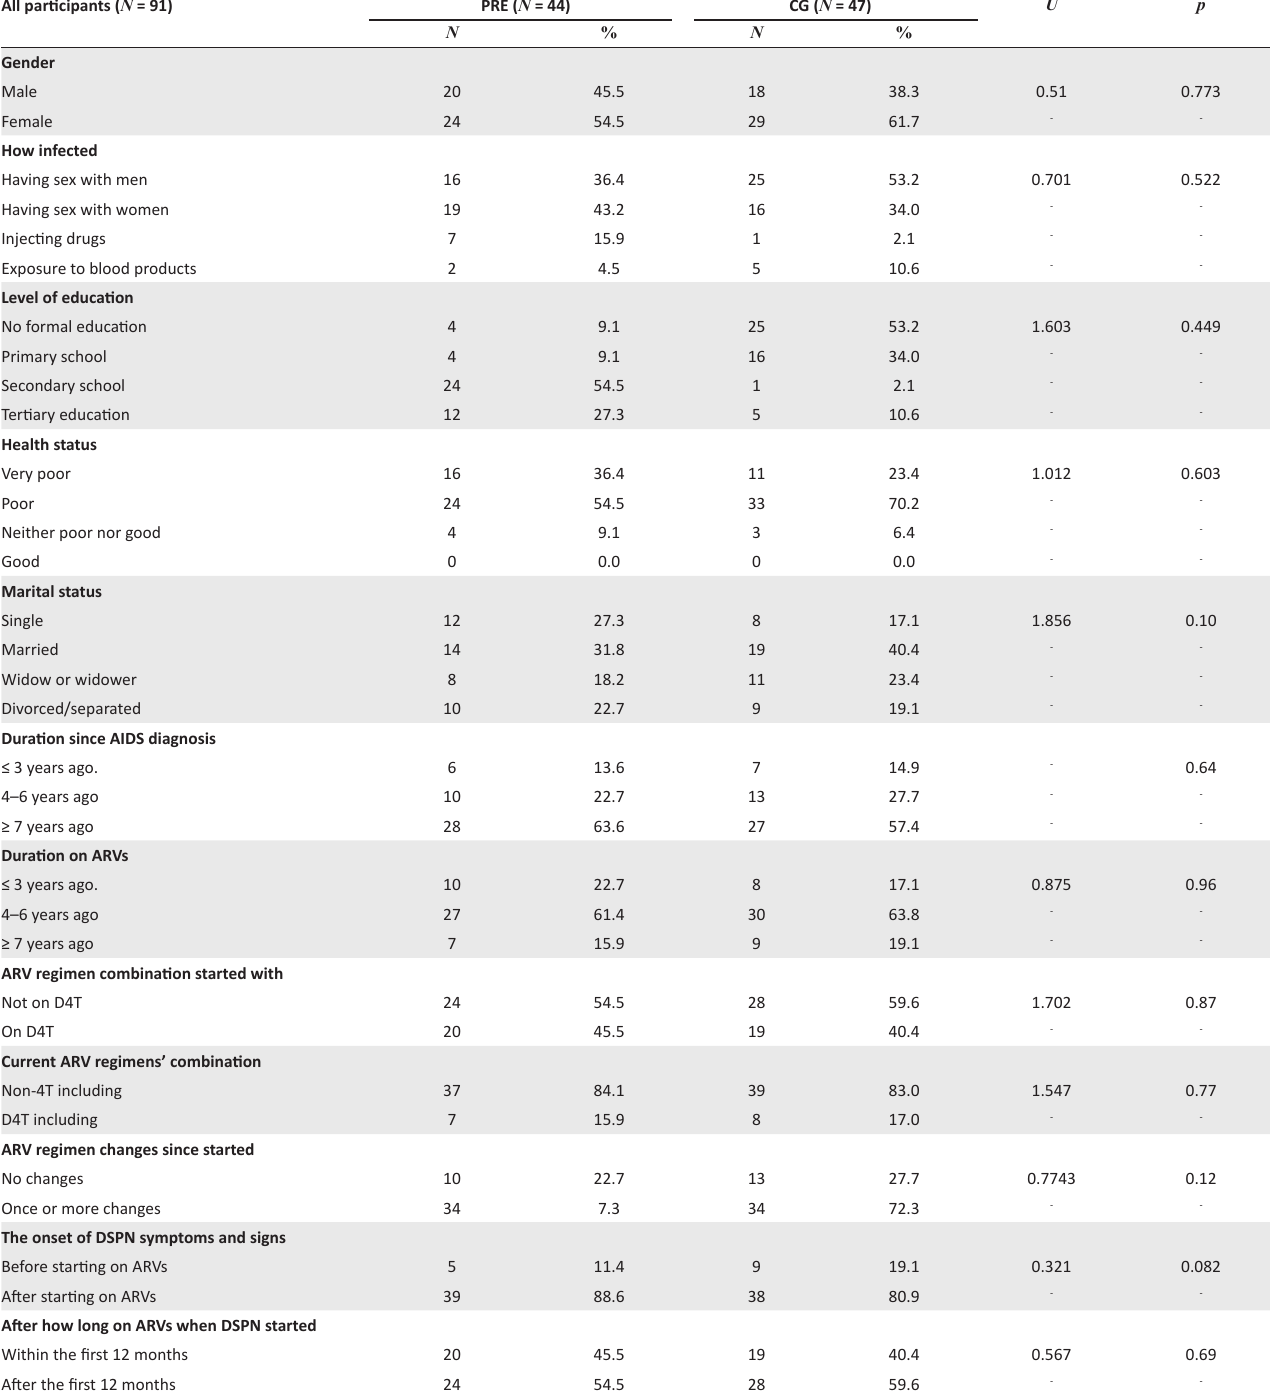
TABLE 1b: Socio-demographic status of the respondents.